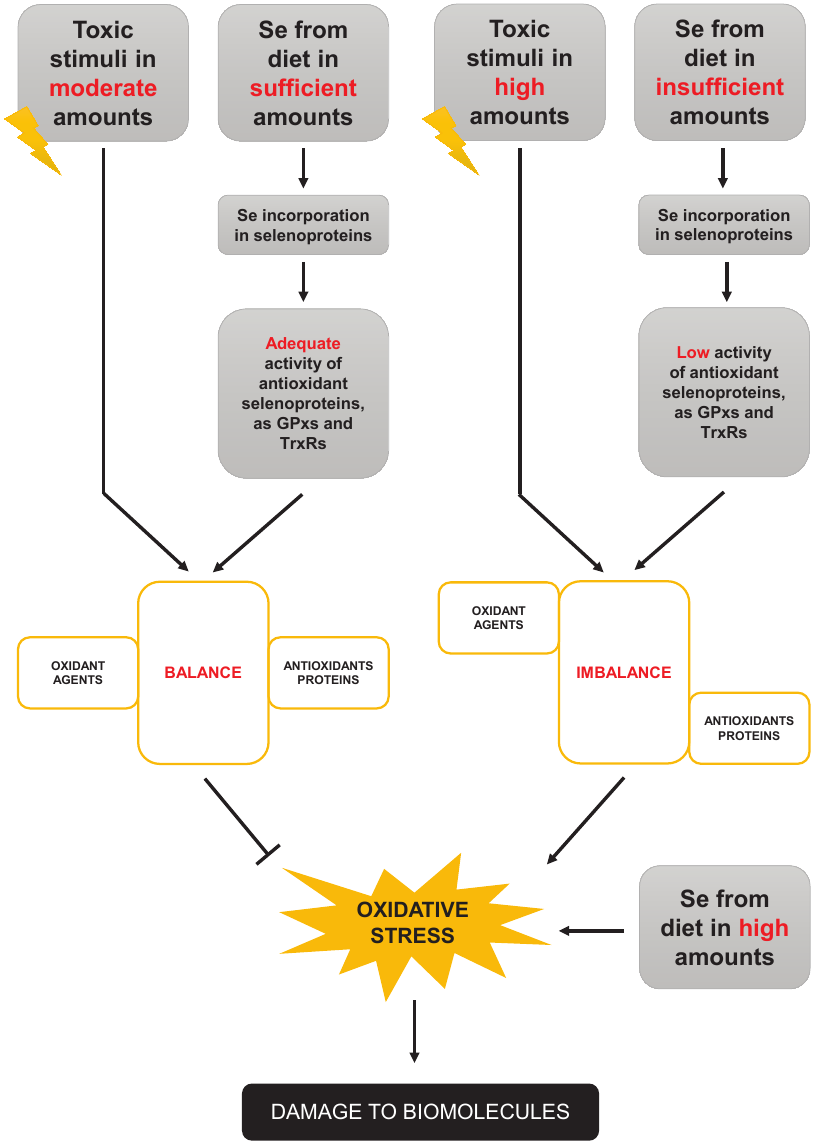
Figure 2 - Main events that influence the antioxidant activity of Se. The Se antioxidant activ - ity occurs through selenoproteins, which are influenced by Se levels obtained through